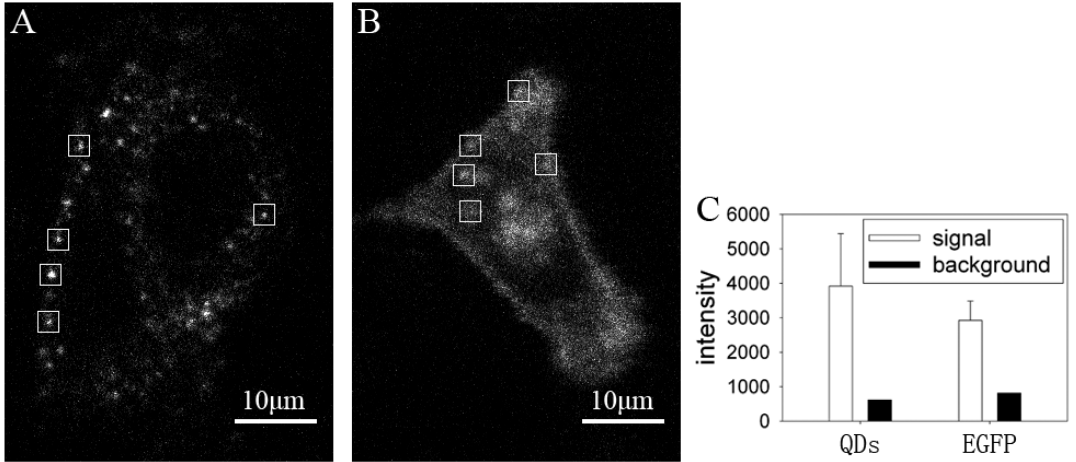
Figure 4. Comparison of the fluorescence images between GLUT4-QDs and GLUT4-EGFP. GLUT4 labeled with QDs and EGFP as described in method, and imaged under confocal microscopy. (A) Fluorescence image of GLUT4-QDs, exposure time was 100 ms. (B) Fluorescence image of GLUT4-EGFP, exposure time was 200 ms. Other imaging parameters were identical across this two fluoroscopic image. (C) Fluorescence intensity analysis of the five 20 × 20 pixel rectangle windows in (A) and (B). White bars represent the mean signal intensity and the lines above white bars represent the difference of mean signal intensity and maximum signal intensity. Black bars represent the background